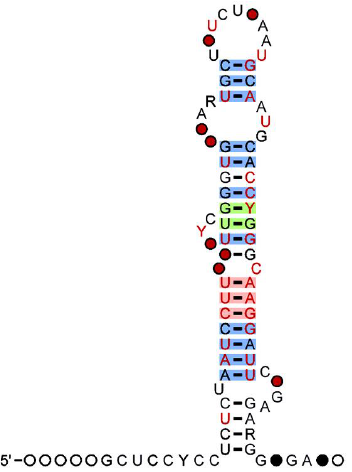
Figure 1. Secondary structure of miR-500 family showing presence of G-C Nucleotide. The 97 percent (%) of G-C nucleotide observed no mutations (Red). The 90 percent (%) of G-C nucleotide conveying mutations (Green) and the 75 percent (%) G-C nucleotide with compatible mutations (Source: useast.ensembl.org) (accessed on 25 February 2023).